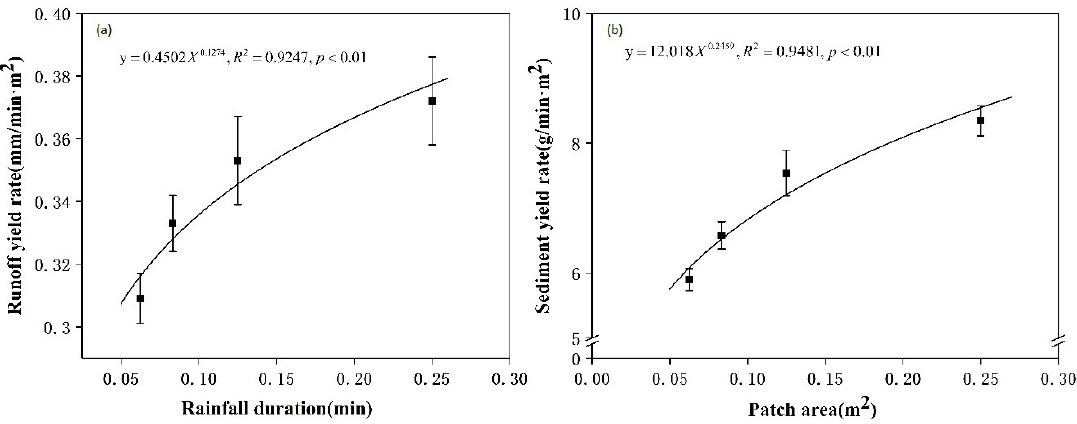
Figure 6. Between the rate of runoff ( a ), sediment transport ( b ), and patch area within an experiment.